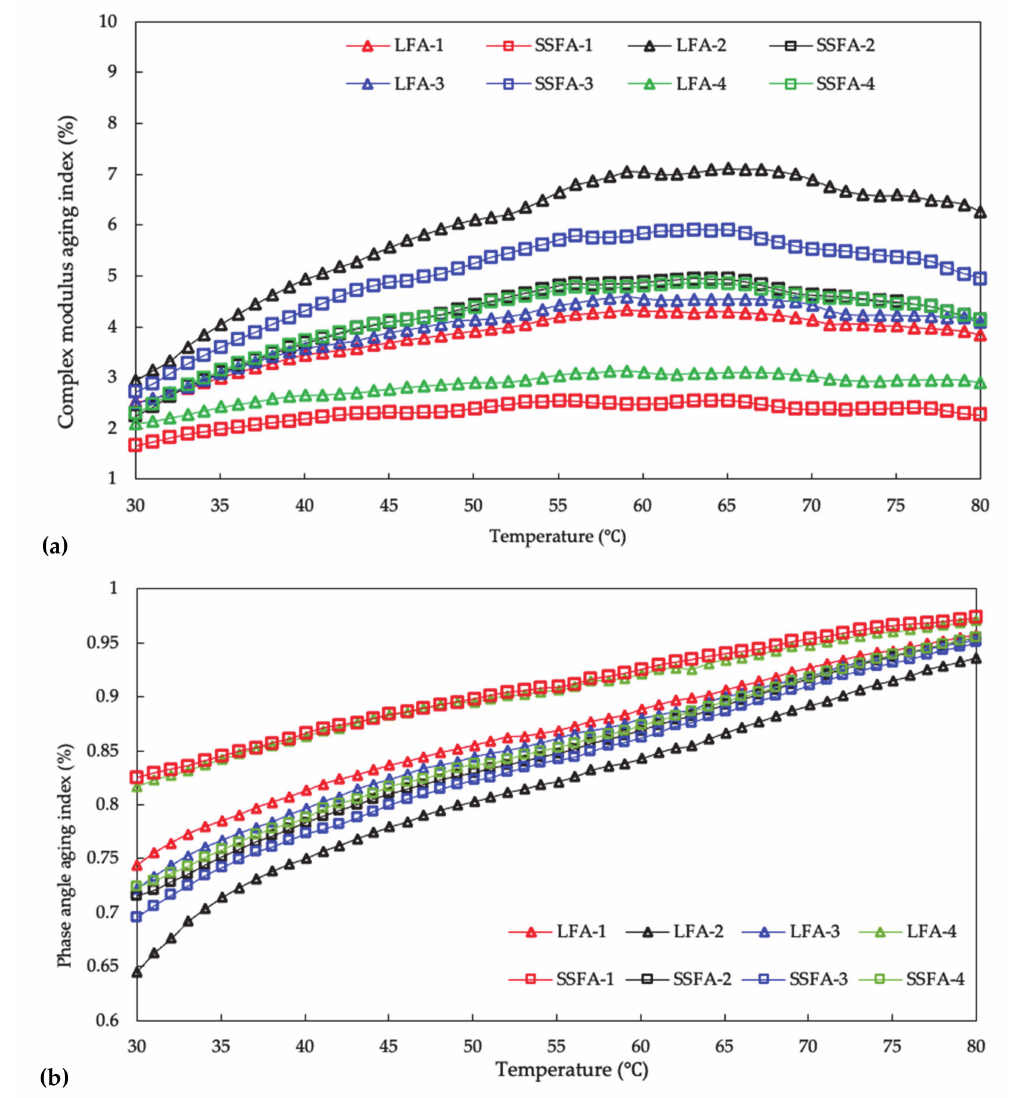
Figure 8. The changes of rheological properties of SSFA and LFA before and after solution aging. ( a ) Complex modulus aging index; ( b ) phase angle aging